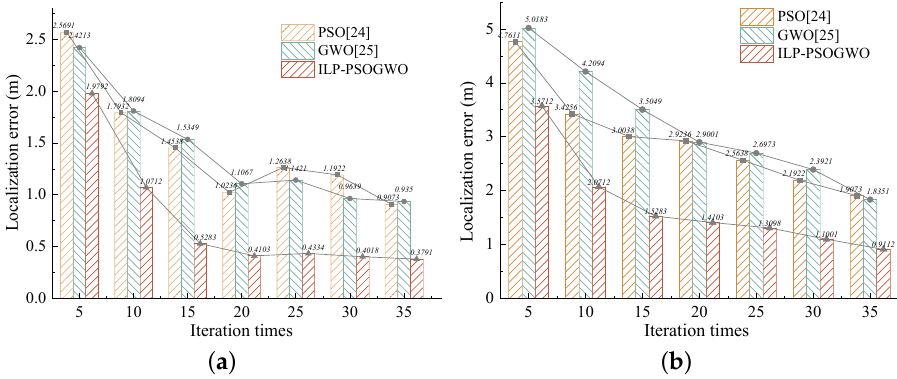
Figure 15. Impact of iteration times on localization error. ( a ) LOS. ( b )